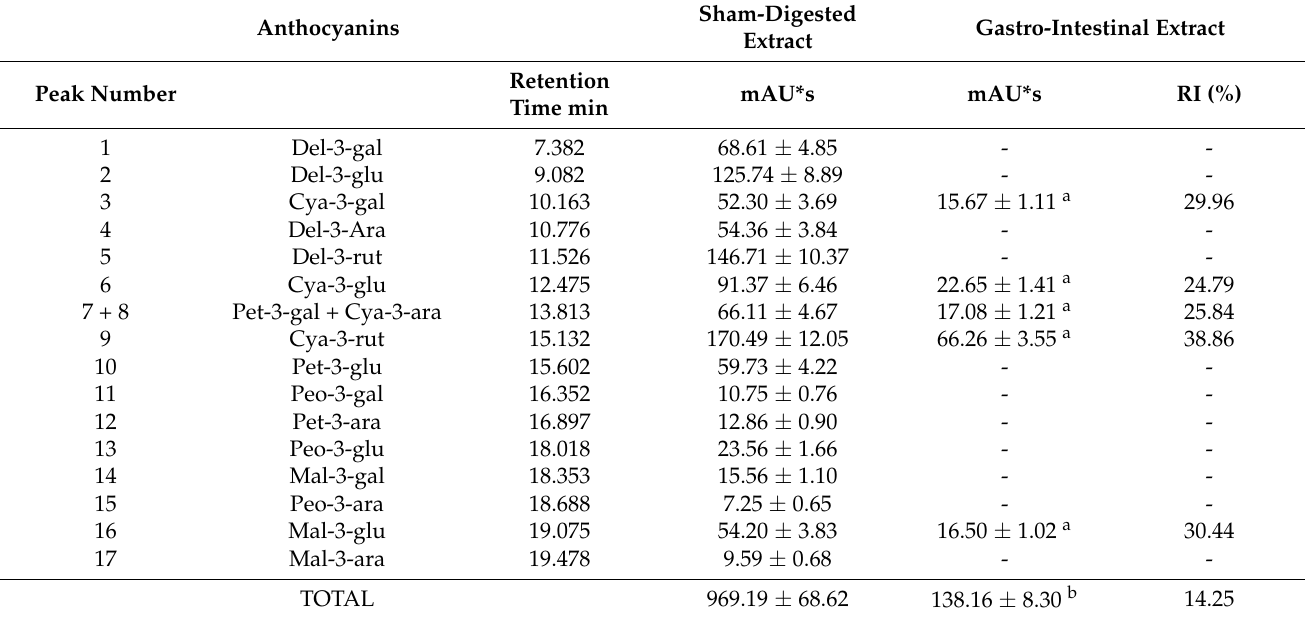
Table 1. Anthocyanins profile and stability of BBE before and after in vitro intestinal digestion, as determined by HPLC/DAD. Data represent peak area (mAU*s) at 520 nm. RI% is the recovery index of each ACN in the intestinal phase vs. the initial content in sham-digested extract. Results are expressed as ± SD of three different experiments a p < 0.05 vs. respective ACN from sham-digested extract, b p < 0.05 vs. sham-digested